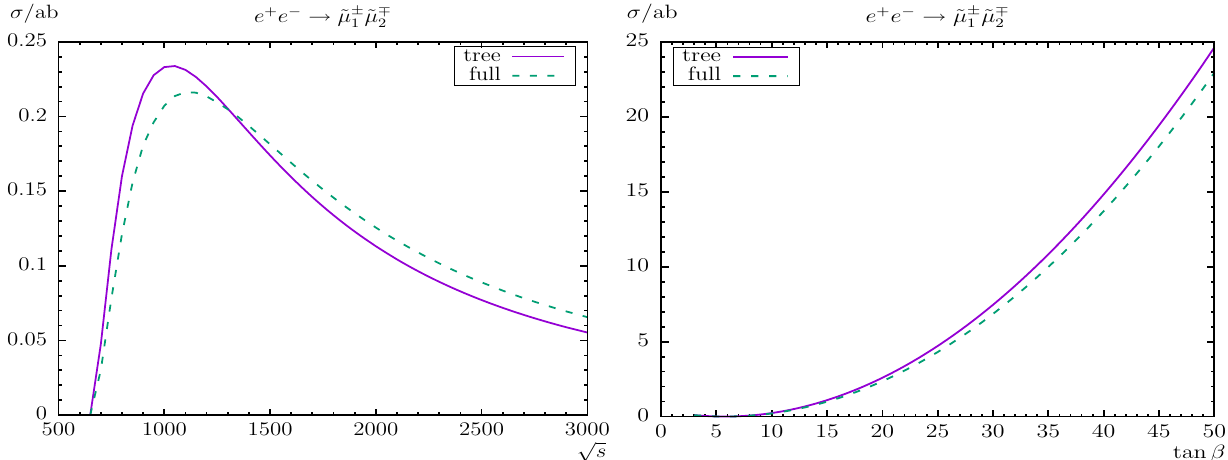
˜ μ − ) . Tree-level and full one-loop corrected cross sections are shown with parameters chosen according to S ; see Table 1. Fig. 12 σ( e + e − → ˜ μ + √ 1 1 s (left) and M ˜ The plots show the cross sections with (right) varied. All masses and energies are in GeV E